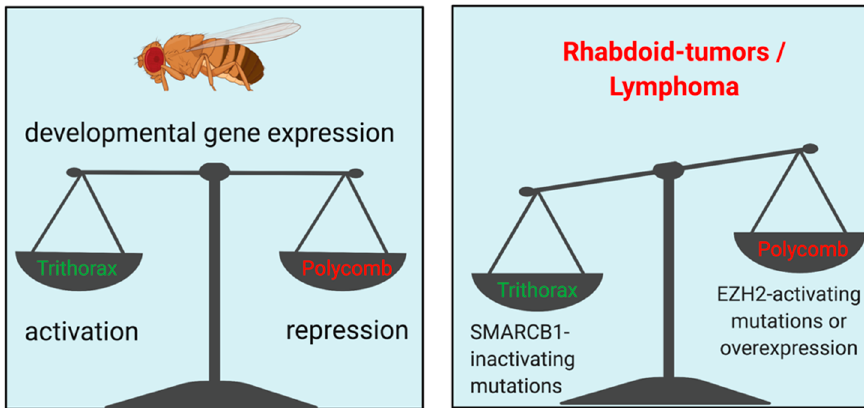
Figure 2. Illustration of the balance between polycomb-mediated repression and trithorax-mediated activation of developmental gene expression programs. Embryonic development and cellular differentiation are regulated by a fine balance between activating and repressive mediators of gene expression and chromatin state ( left ). In rhabdoid tumors and certain lymphomas, this balance is shifted towards a dominance of the polycomb-repressive complex ( right ).